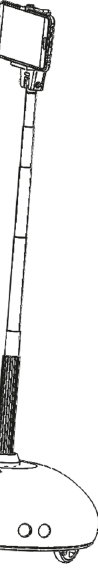
Figure 1: Dali social robot.